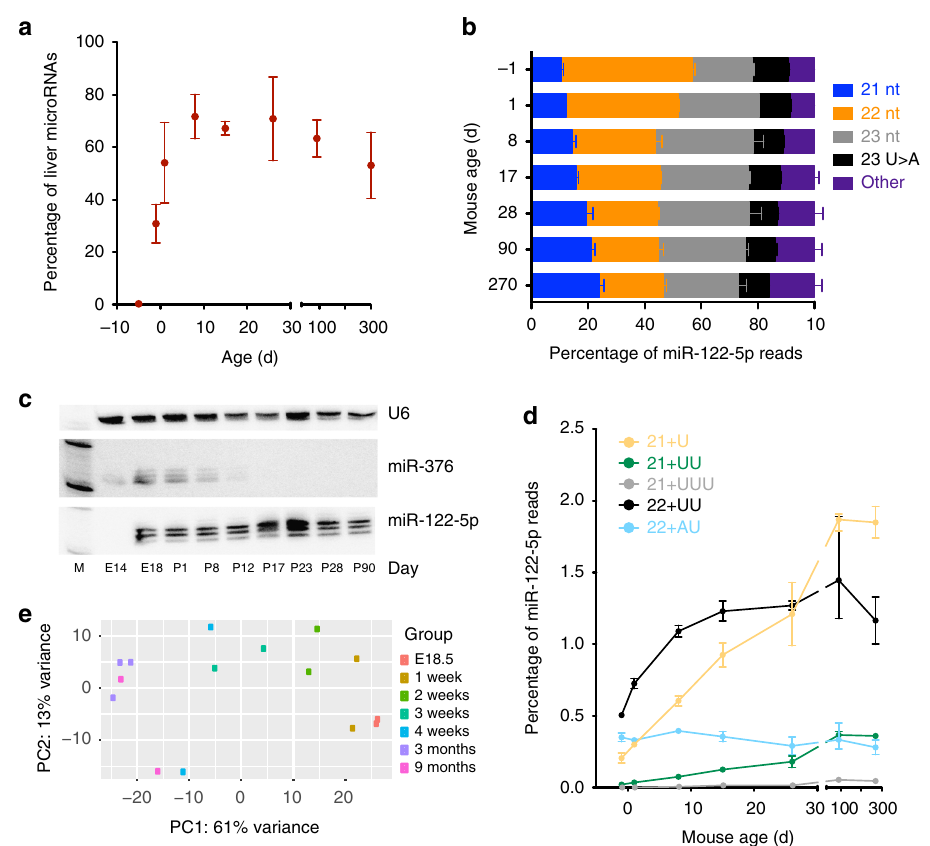
Fig. 2 Levels of miR-122 and its various isoforms in the developing mouse liver. a Percentage of reads that map to miR-122 relative to all microRNAs in mouse embryonic and adult livers ( n = 2 mice per condition, shown are mean and range). b miR-122-5p predominant isoforms at various peri- and postnatal time points. c Small RNA northern blot of miR-122 levels. d Abundance of rare miR-122-5p isoforms relative to all microRNA reads ( n = 2 mice per condition, shown are mean and range). e Principle component analysis of mouse liver small RNA-seq reads at various